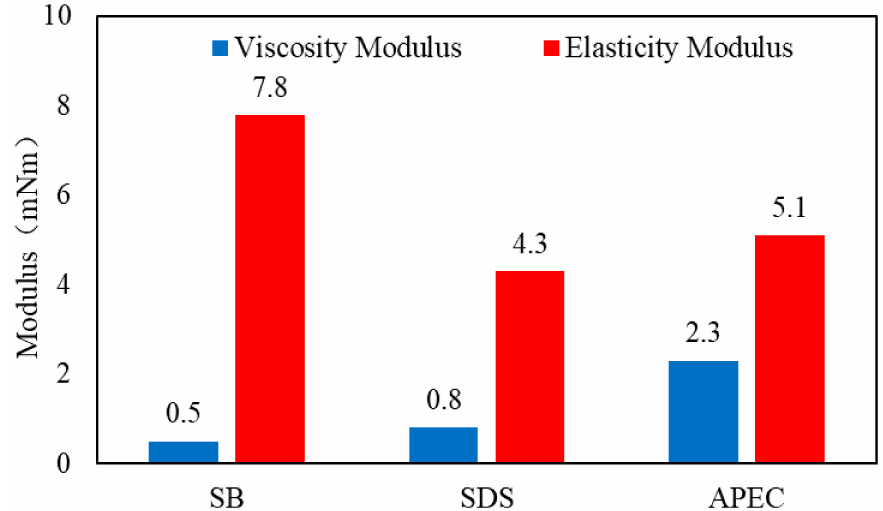
Figure 4. Viscoelastic modulus of different foaming agents: Sodium Dodecyl Sulfate (SDS), Sulphobetaine (SB), Sodium Alkyl Phenol Polyoxyethylene Ether Carboxylate (APEC).